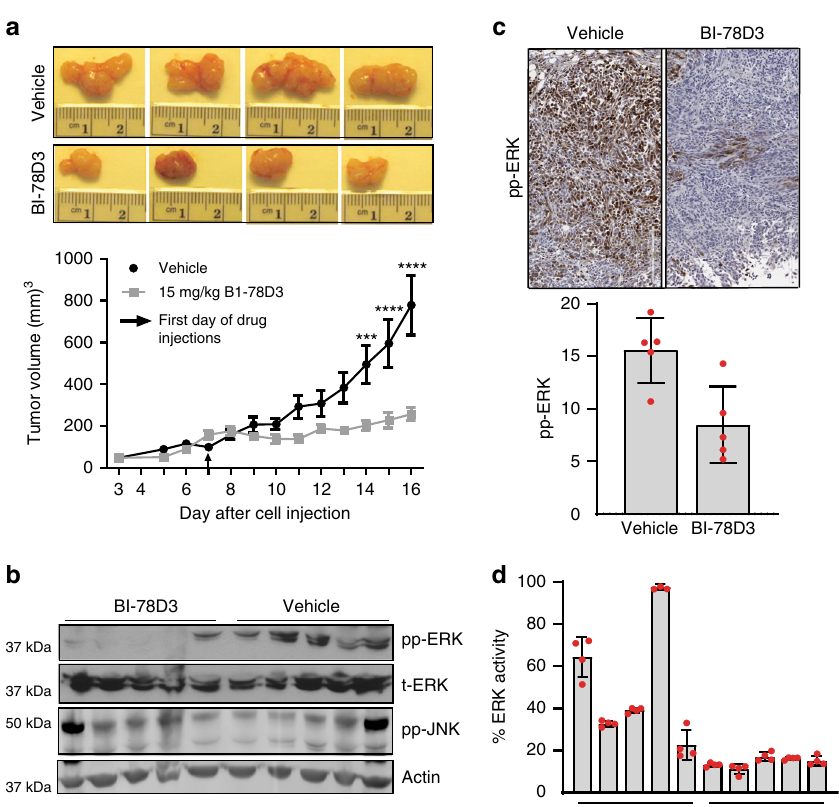
Fig. 5 BI-78D3 inhibits ERK in human BRAF- mutant A375 xenograft model. a Female athymic nude mice were injected subcutaneously with A375 cells. Once the tumor volume reached 150 mm 3 , mice were randomly divided into two groups ( n = 10) and dosed daily with vehicle or BI-78D3 (15 mg kg − 1 by intraperitoneal administration) for 10 days. Tumor volumes were measured daily by caliper, and the values plotted as mean ± SEM; *** P < 0.001; **** P < 0.0001; data were analyzed following a two-way repeated measures ANOVA using the Bonferroni post-test method (GraphPad Prism 7 software). b To con fi rm target engagement of BI-78D3, tumor lysates from fi ve mice of each group were subjected to western blotting and analyzed for pp-ERK1/2, ERK, pp- JNK , and β -actin (loading control). Images are cropped for presentation; uncropped images are shown in Supplementary Fig. 25. c Formalin- fi xed paraf fi n- embedded tumor sections were subjected to immunohistochemistry. Representative images of the tumor sections stained with pp-ERK are shown. Comparisons of stained cells normalized to mm 2 of tumor area revealed signi fi cant suppression of pp-ERK in treated mice (the values were plotted as mean ± S.D., n = 5 for each group). d Estimated amount of active ERK in tumor lysates from fi ve mice of each group, obtained using peptide-based biosensors and chemometric modeling using calibration regression model as described in Zamora-Olivares et al. 53 (the values were plotted as mean ± SEM, n = 4 for each